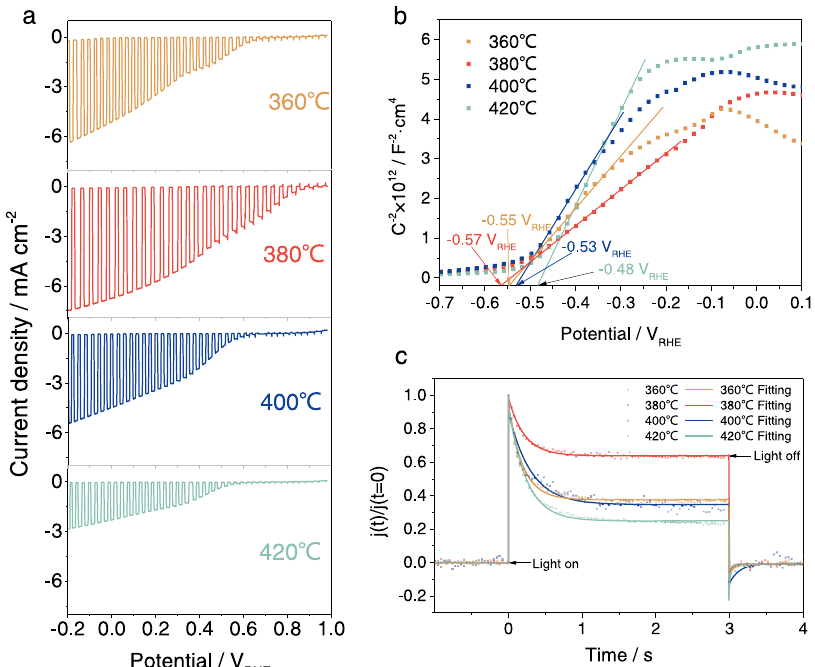
Fig. 2 Performance and charge transfer dynamics characterization of the Cu 3 BiS 3 -based photocathode sprayed at various substrate temperatures. ( a ) Chopped photocurrent density-potential curves, ( b ) corresponding Mott – Schottky curves and ( c ) corresponding transit photocurrent spectra of the Cu 3 BiS 3 -based photocathodes sprayed at various substrate temperatures (360 °C, 380 °C, 400 °C and 420 °C). Source data are provided as a Source Data fi